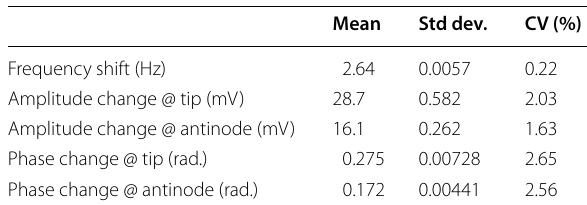
Table 1 Summary of statistical analysis for repeated